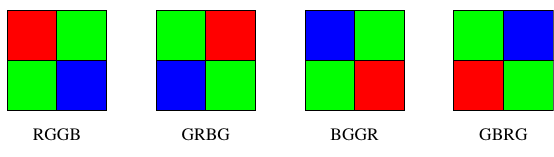
Figure 1. Different configurations of Bayer